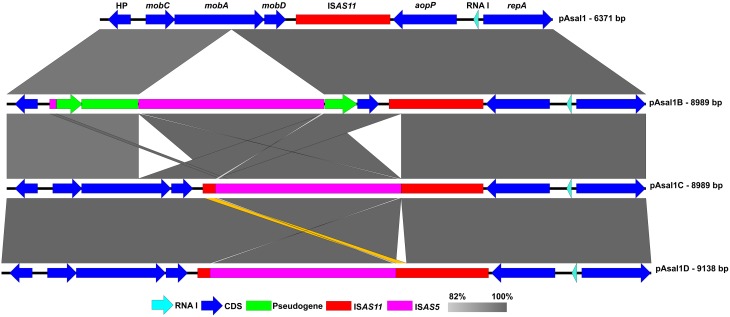
Comparison of pAsal1 (JF2267), pAsal1B (HER1104), pAsa1C (JF2506), and pAsal1D (JF2507). The dark and light blue arrows represent coding sequences (CDSs) and the RNA I regulator, respectively. The purple and red rectangles represent ISAS5 and ISAS11, respectively, while the green rectangles represent pseudogenes. The gray zones represent high identity regions of the sequences. The orange zone indicates the difference between pAsal1C and pAsal1D. The CDSs related to transposases and a 3′ part of the truncated mobA were not added for purposes of clarity. The complete map of pAsal1 is given in Figure S1.